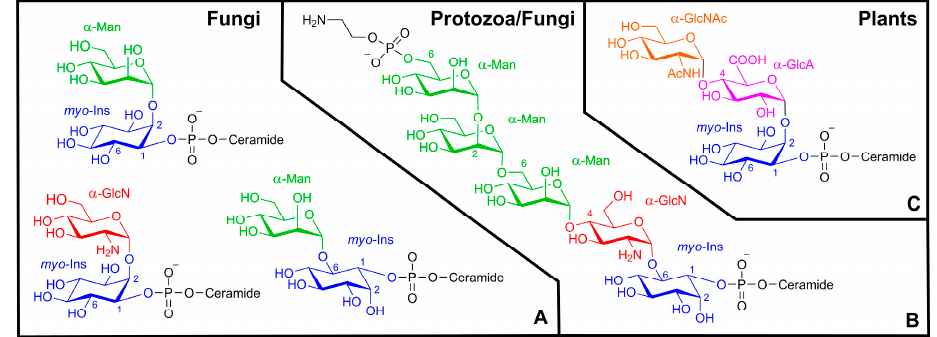
Figure 3. Core structures of known natural GIPCs. ( A ) The three core structures (Man(1 α → 2) myo - inositol-1-PO 4 -Cer, Man(1 α → 6) myo -inositol-1-PO 4 -Cer, and GlcN(1 α → 2) myo -inositol-1-PO 4 -Cer) of GIPCs found in fungi; ( B ) The core structure (ethanolamine-PO 4 -6-Man(1 α → 2)Man(1 α → 6)Man(1 α → 4) GlcN(1 α → 6) myo -inositol-1-PO 4 -Cer) of GPI-anchors based on a ceramide lipid moiety found in fungi and protozoa; ( C ) The core structure (GlcNAc(1 α → 4)GlcA(1 α → 2) myo -inositol-1-PO 4 -Cer) of GIPCs found in plants. Abbreviations: Ins: inositol; Glc: glucose; GlcN: 2-amino-2-deoxyglucose (glucosamine); GlcNAc: 2-acetamido-2-deoxyglucose ( N -acetylglucosamine); GlcA: glucuronic acid; Man: mannose.